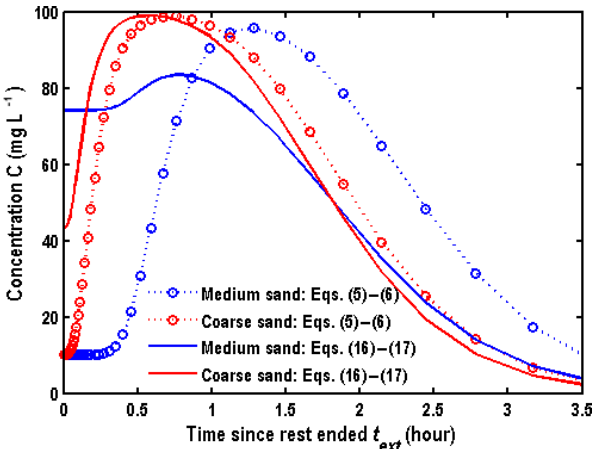
Figure 5. The BTCs in the wellbore for the different boundary con- ditions at the wellbore in the injection and chase